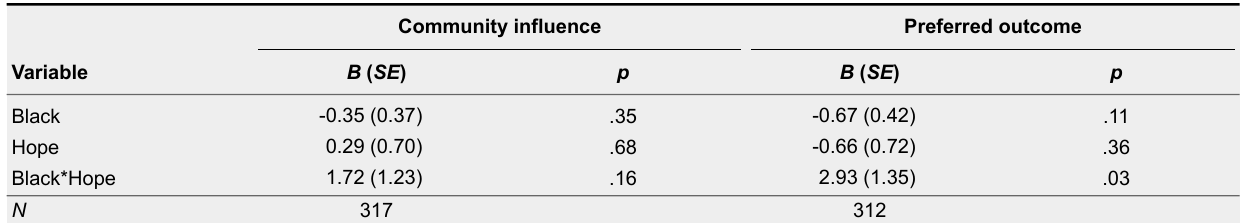
Ordered Logit Models Interacting Subject Race and Reported Hope on Group Efficacy and Environment